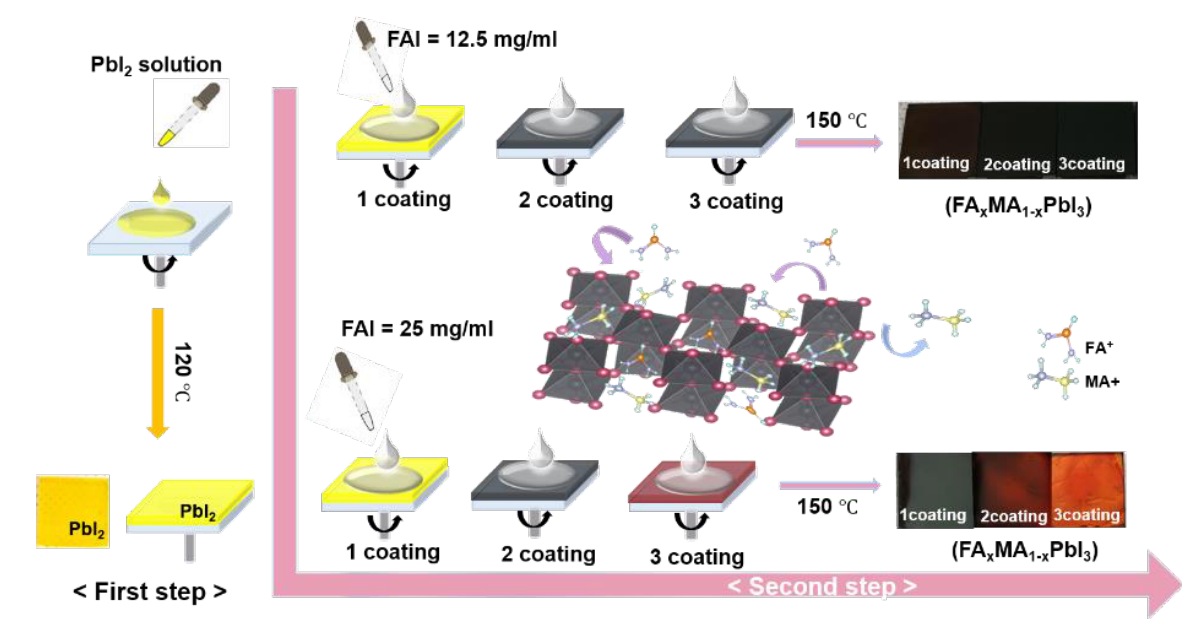
Figure 1. Synthesis of FA x MA 1-x PbI 3 films using mixed FAI – MAI precursors.